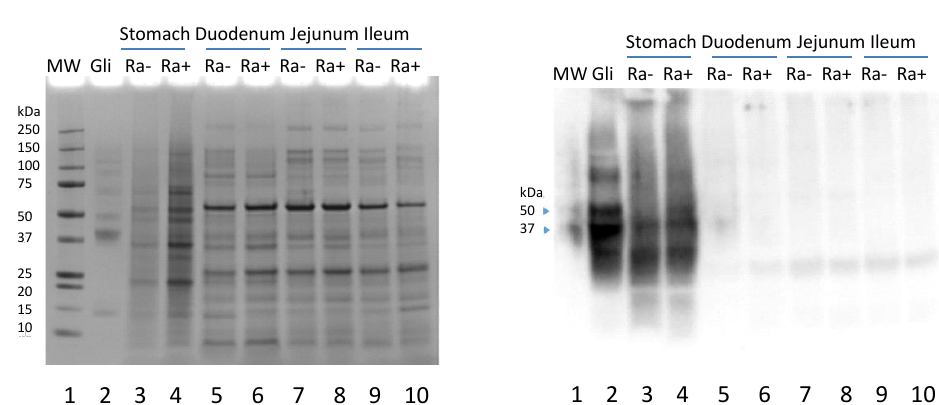
Figure 1. Analysis of gastric and small intestinal contents. ( A ) Total protein content of the contents in the stomach (red) and small intestine (orange); n = 4 per organ; protein was determined by the BCA method multiplied by sample volume and divided by the total protein in both the stomach and intestine. ( B ) Analysis of gliadin in gastro-intestinal samples by SDS-PAGE (left panel) and anti-gliadin immunoblotting (right panel). Aliquots (63 µ g protein) of the gastro-intestinal samples with R. aeria (Ra + ) and without R. aeria (Ra − ) bacteria were loaded on two 4–12% SDS-PAGE gels. After electrophoresis at 120 V, the gels were either stained with Coomassie brilliant blue (left) or processed by immunoblotting with an anti-gliadin antibody (right). Lanes 1: Protein standard, 5 µl; 2: Gliadin control (Gli, 25 µg); 3: stomach Ra (-);4: stomach Ra (+);5: duodenum Ra (-);6: duodenum Ra (+); 7: Jejunum Ra (-);8: jejunum Ra (+); 9: ileum Ra (-); 10: ileum Ra (+). Arrows: gliadin bands at 37 and 50 kDa.